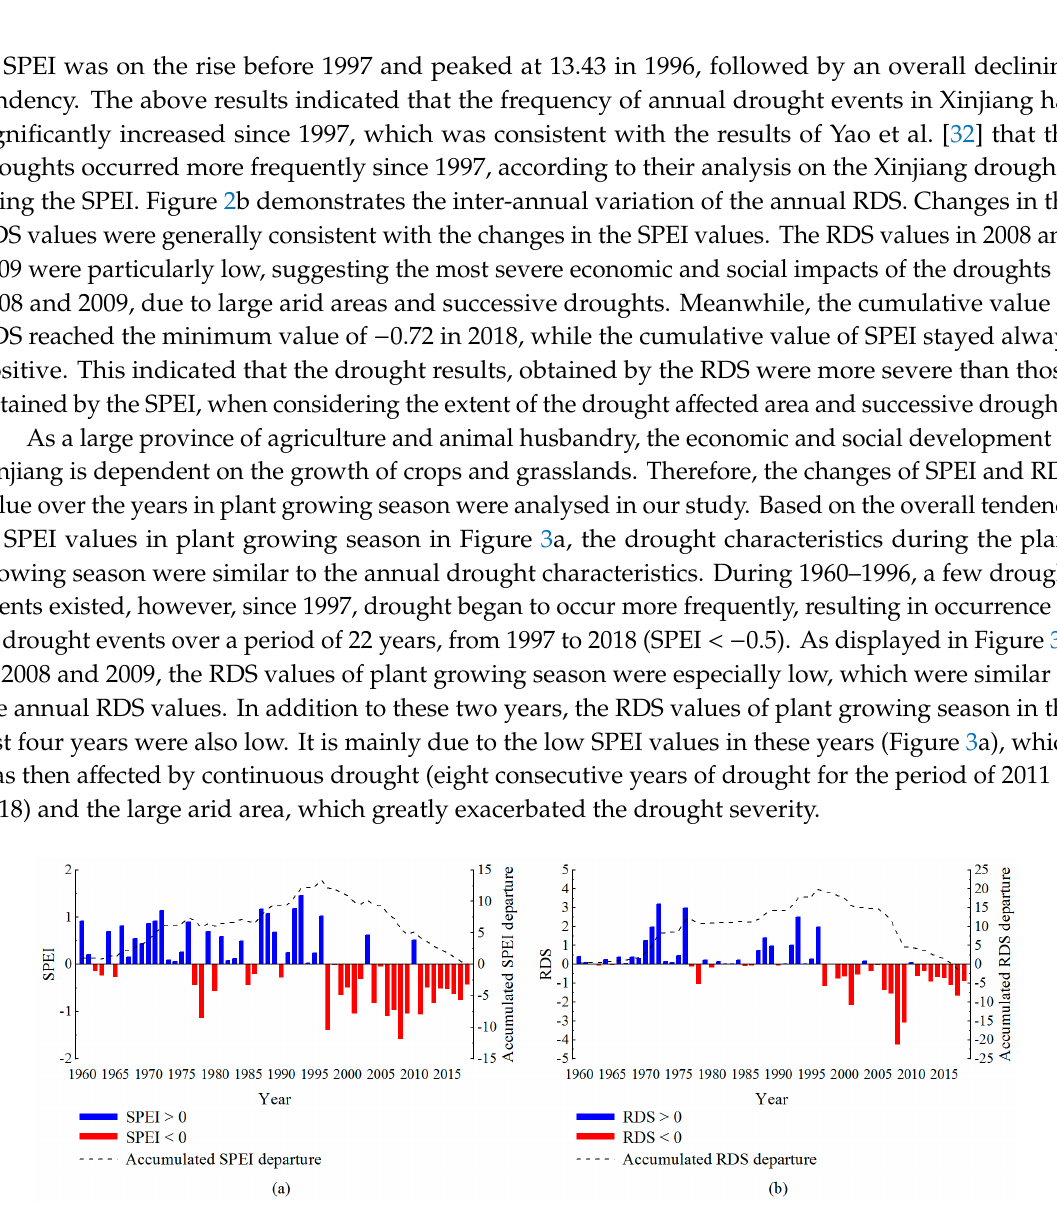
Figure 2. Change characteristics of the annual SPEI values ( a ) and the annual RDS values ( b ), over the years.